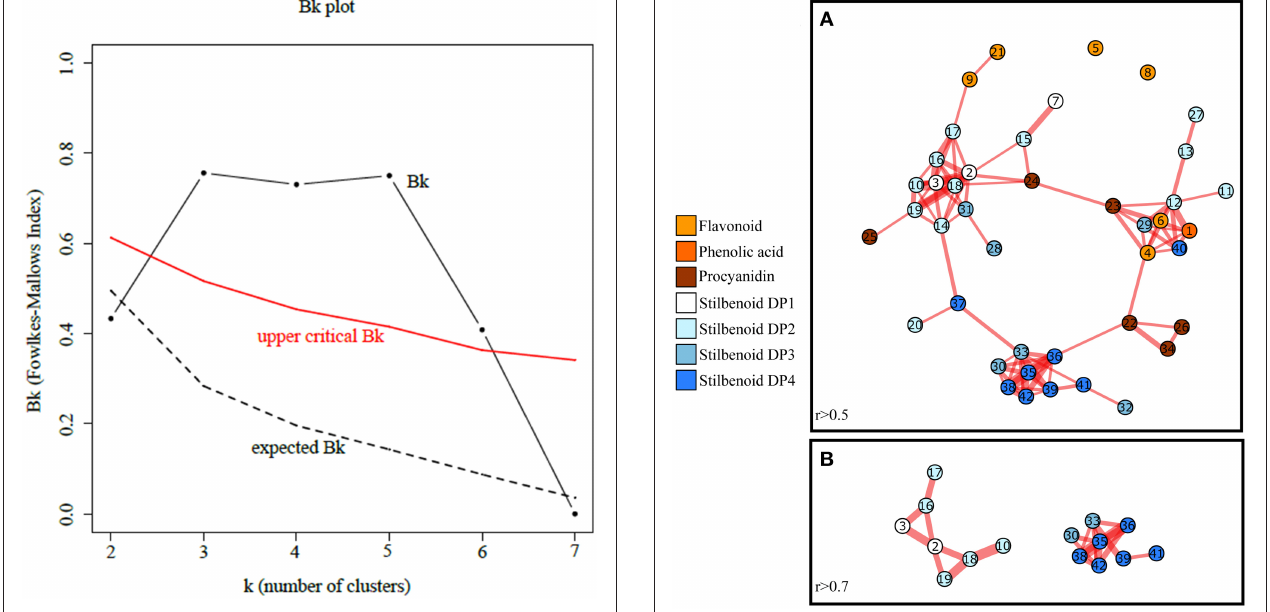
FIGURE 8 | Correlation-based networks of polyphenol metabolism related compounds in grape stems in 2013. Metabolite pairs whose correlation was significant with a minimum correlation coefficient of 0.5 (A) and 0.7 (B) are connected. Nodes represent metabolites and color refers to the class of polyphenols. Node numbers indicate the ID of the compounds as given in Table 2 . Short node distance (Pearson correlation coefficients) and thick lines ( P- values) indicate high